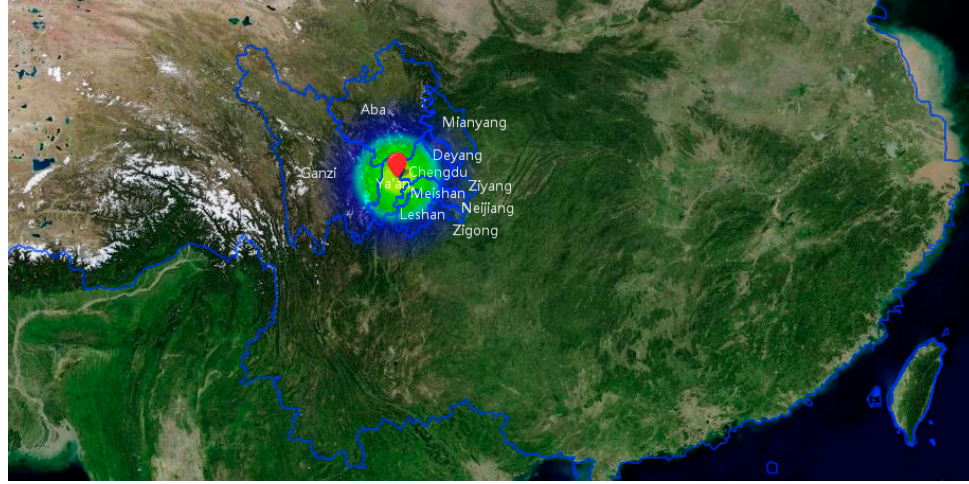
Figure 2. The study area of the 2013 Ya’an earthquake that was used in this paper.